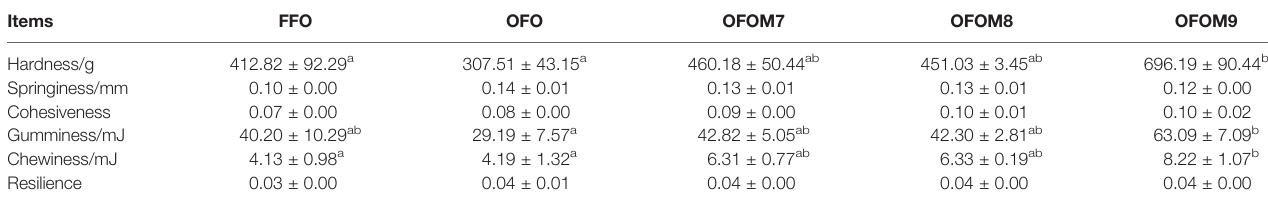
The results are presented as the means ± SEM (n = 3). Values with different superscripts in the same row are signi fi cantly different (p < 0.05).